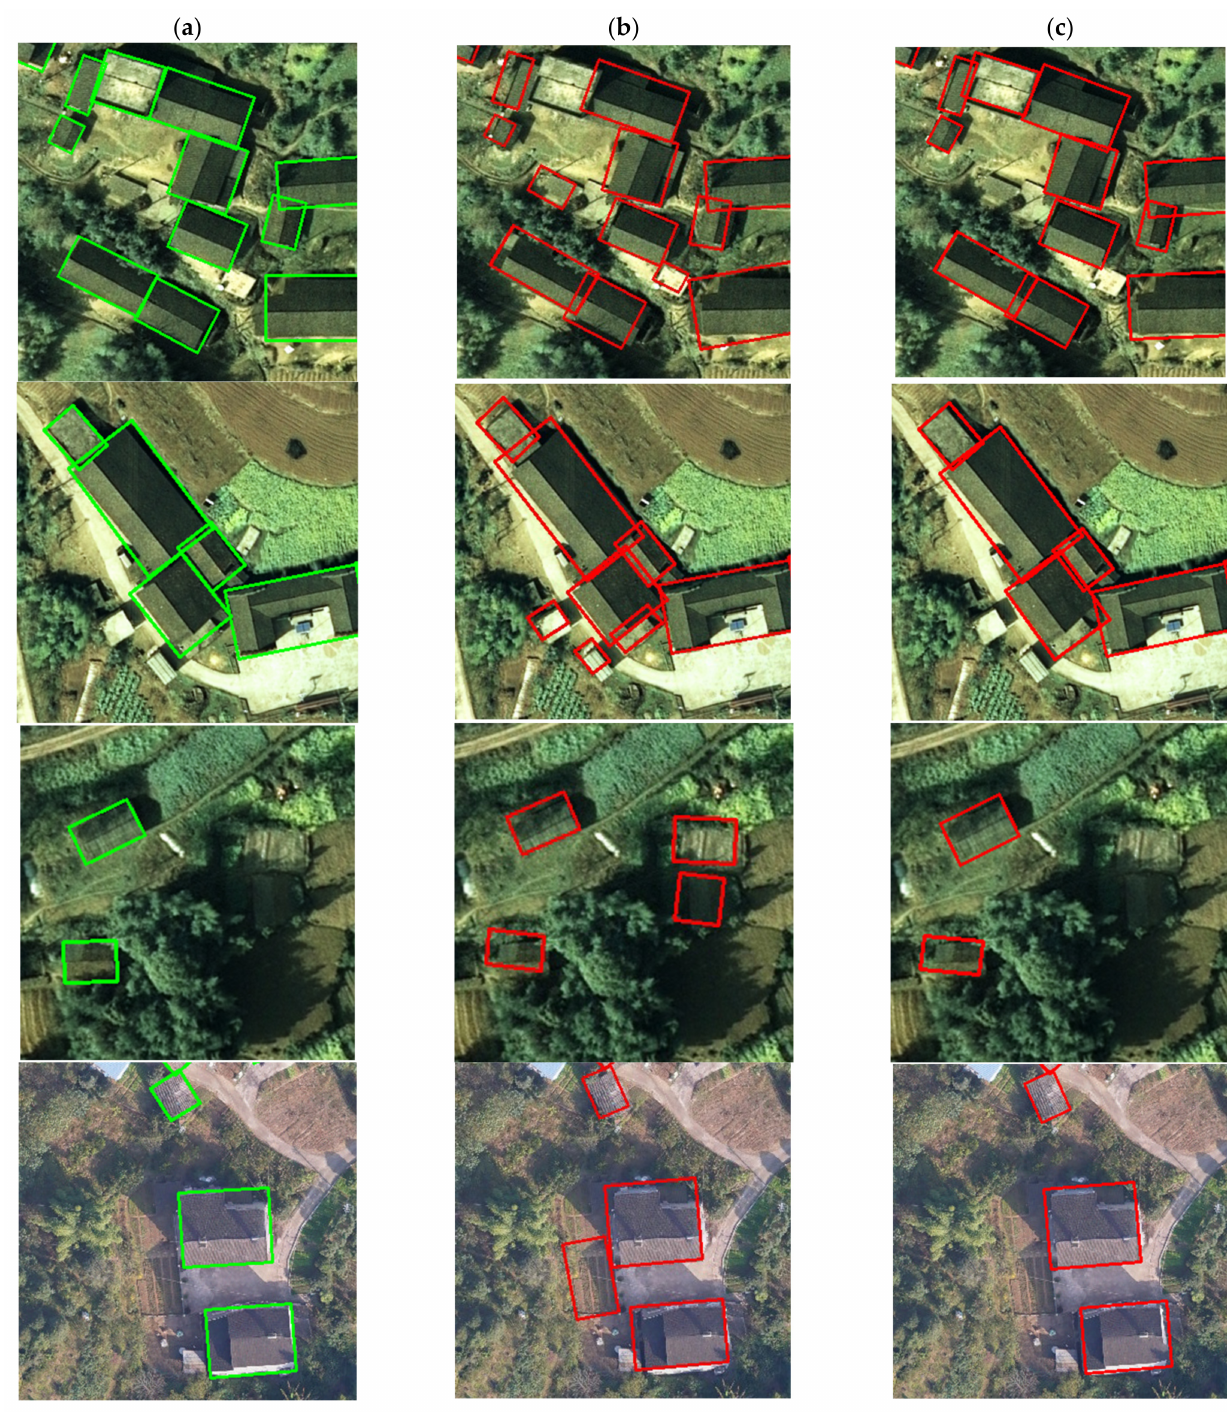
Figure 10. Comparison of detection of R2CNN and TRDet: R2CNN ignores many hard samples and identifies incorrect fields as buildings. ( a ) Are the ground truth bounding boxes of buildings; ( b ) are the R2CNN detection results; ( c ) are TRDet detection